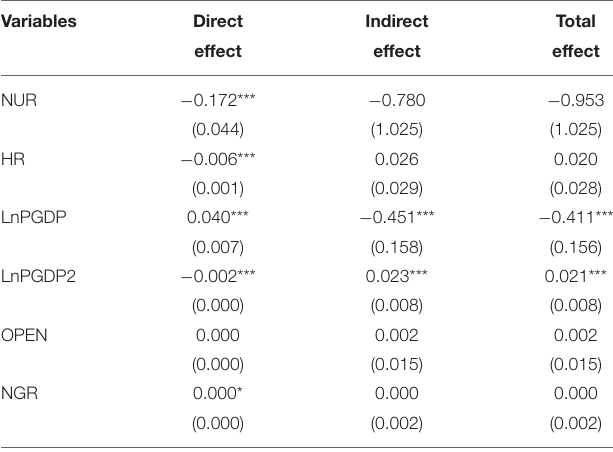
TABLE 6 | Direct and indirect effects of baseline regression.